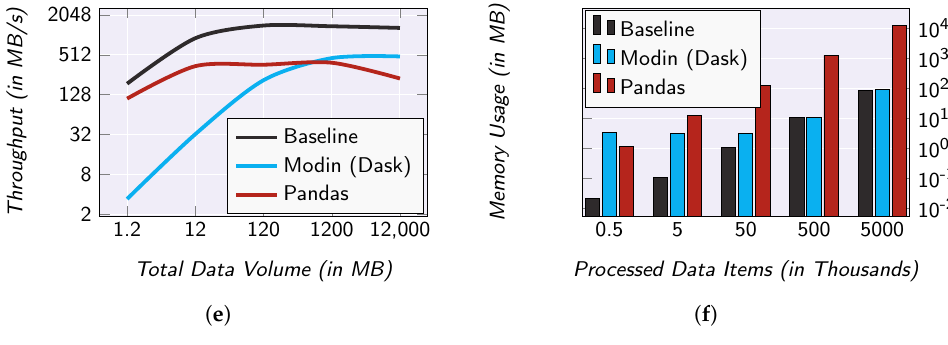
Figure 7. Evaluation results regarding the overhead caused by SMARTEN. ( a ) Data throughput of the filter operator; ( b ) memory usage of the filter operator; ( c ) data throughput of the map operator; ( d ) memory usage of the map operator; ( e ) data throughput of the reduce operator; ( f ) memory usage of the reduce